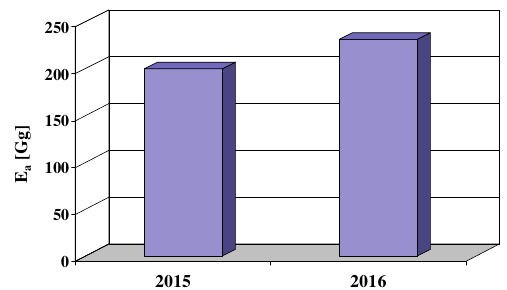
Fig. 7. National annual emission of nitrogen oxides from motor vehicles in 2015 and 2016